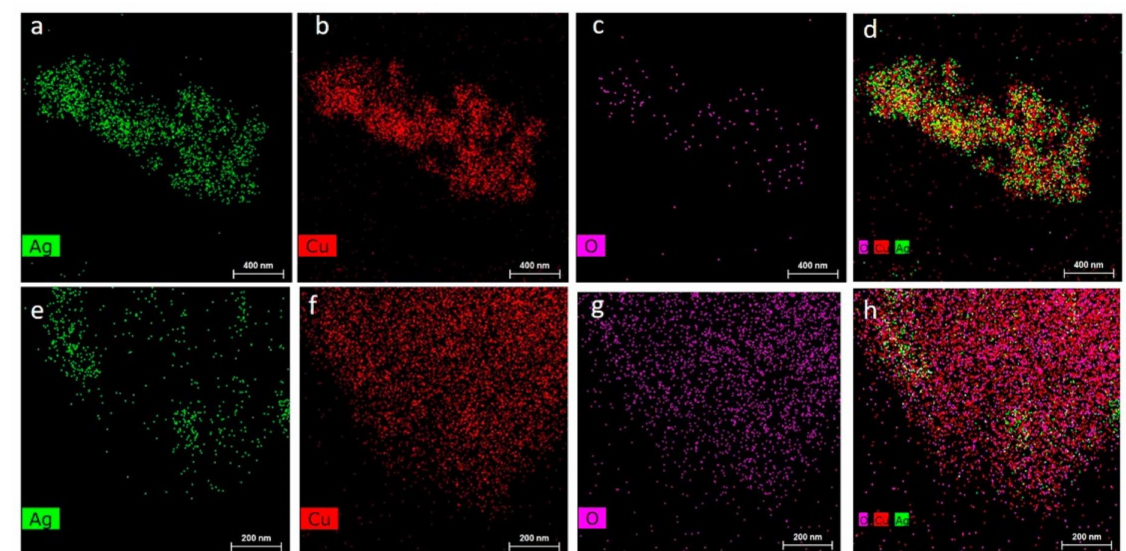
Figure 5. Energy-dispersive X-ray mapping for corresponding elemental distribution of Ag, Cu, and O on Ag 2 Cu 1 ( a – d ) and AgCuO x NPs ( e – h ). Reprinted from [89] with permission from ACS Publications. Table 2. Comparison of full NH 3 conversion and N 2 selectivity in same temperature range over Ag-based catalysts reported. Catalyst Catalyst Preparation Reaction Conditions